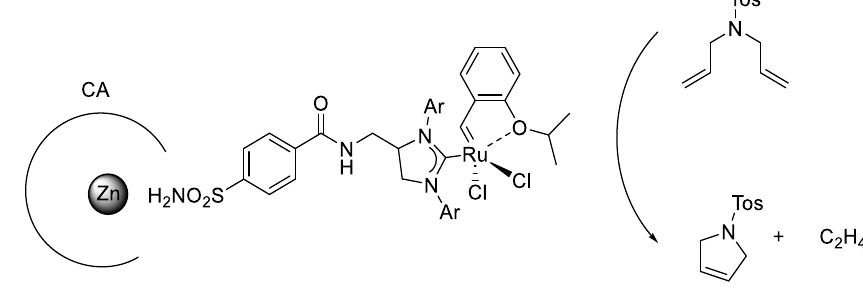
Figure 8. Artificial metalloenzyme for ring-closing metathesis.